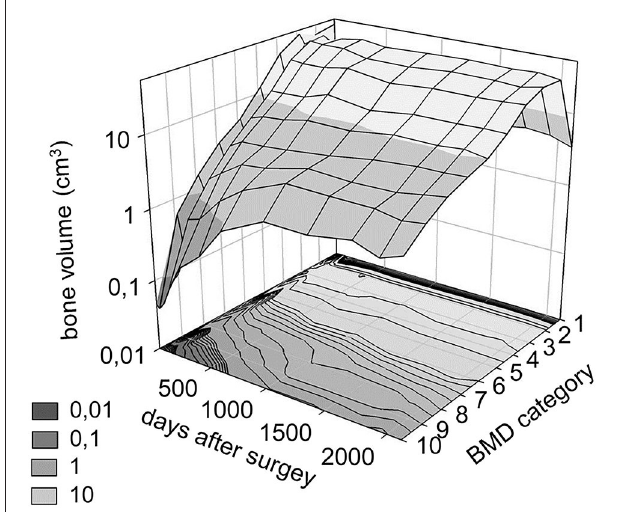
FIGURE 9 | Distribution of bone volume in the 10 BMD category over the follow up period. The bone volume is defined using the FE mesh voxel dimensions. The BMD categories from 1 to 10 correspond to the color code from (8) (1st category = 0 g/cm 3 , 10th category 1.12 g/cm 3